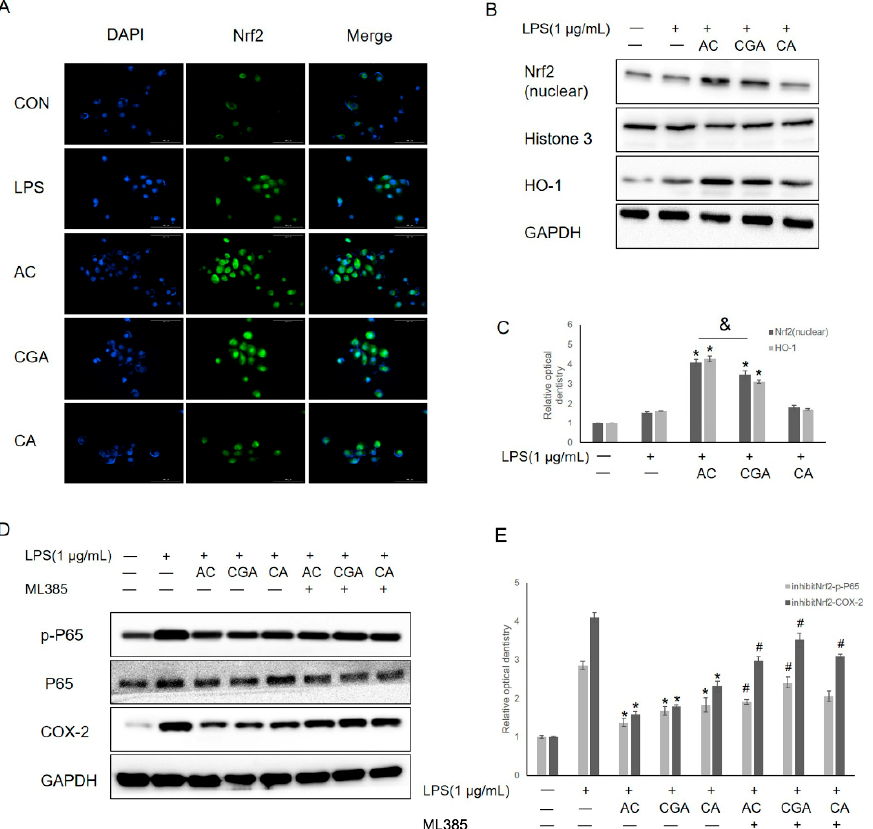
Figure 5. The effects of AC, GA, and CA on Nrf2 translocation. ( A ) The immunofluorescence staining was used to observe Nrf2 location via green fluorescence. 4‘,6-diamidino-2-2phenylindole (DAPI) was used to show the location of nucleus via blue fluorescence. ( B ) Nuclear Nrf2 and HO-1 expression levels were determined by Western blot. ( C ) Relative optical density was measured using Image J software. ( D ) The expression levels of p-NF- κ Bp65, NF- κ Bp65, and COX-2 were determined by Western blot. ( E ) Relative optical density was measured using Image J software. * p -value < 0.05. vs. LPS only treated control. # p -value < 0.05. vs. ML385 untreated control. & p -value < 0.05 (AC vs. CGA). “ - ” represent untreated group; “+” represent treated with LPS or ML385 group.